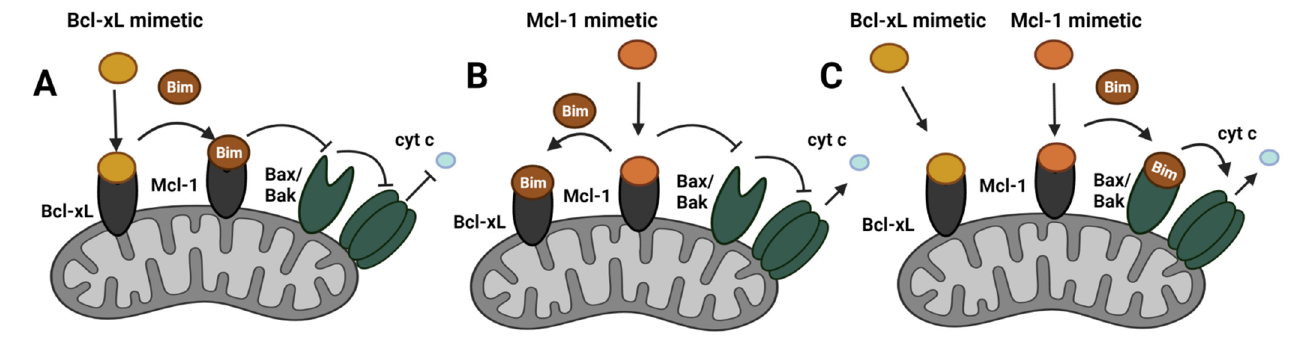
Figure 7. The compensatory role of Mcl-1 and Bcl-xL in resistance toward BH3 mimetics in ER+ breast cancer ( A ) The binding of the BH3 mimetic to Bcl-xL enables the translocation of Bim from Bcl-xL to Mcl-1, thus preventing the activation of Bak/Bax by Bim. ( B ) Binding of the Mcl-1 mimetic releases Bim, which binds to Bcl-xL. ( C ) The binding of both Bcl-xL and Mcl-1 with the corresponding BH3 mimetics enables the binding of Bim with pore-activating proteins Bax/Bak leading to their oligomerization and subsequent release of cytochrome c from the mitochondrial intermembrane space. Created with BioRender.com (accessed on 5 December 2021).